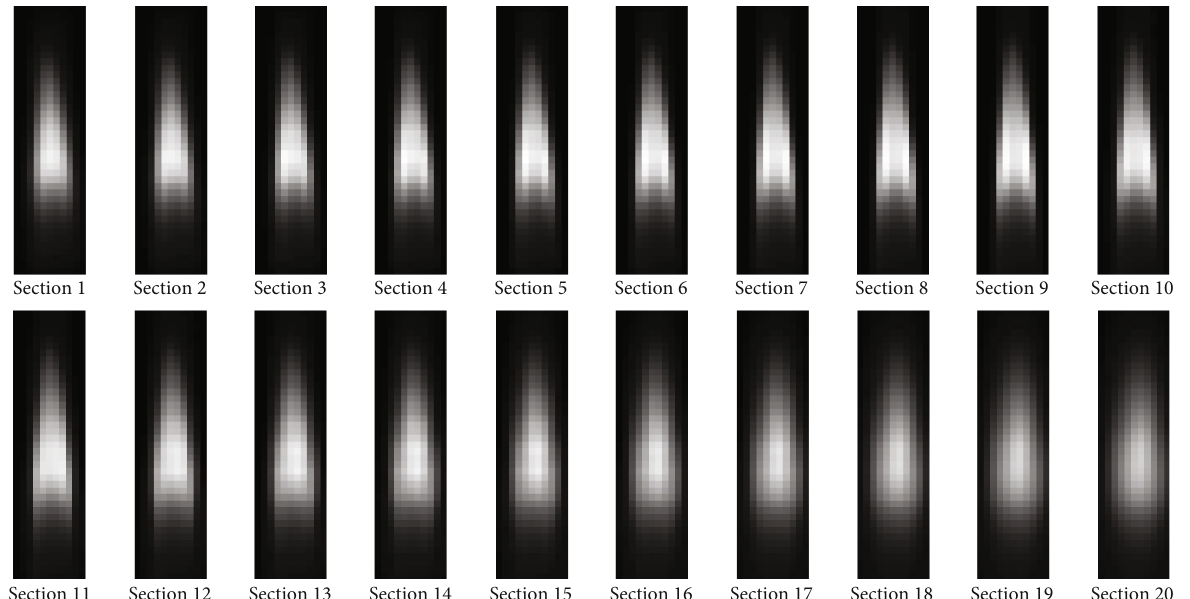
Figure 17: The refocus image sequences of the candle fl